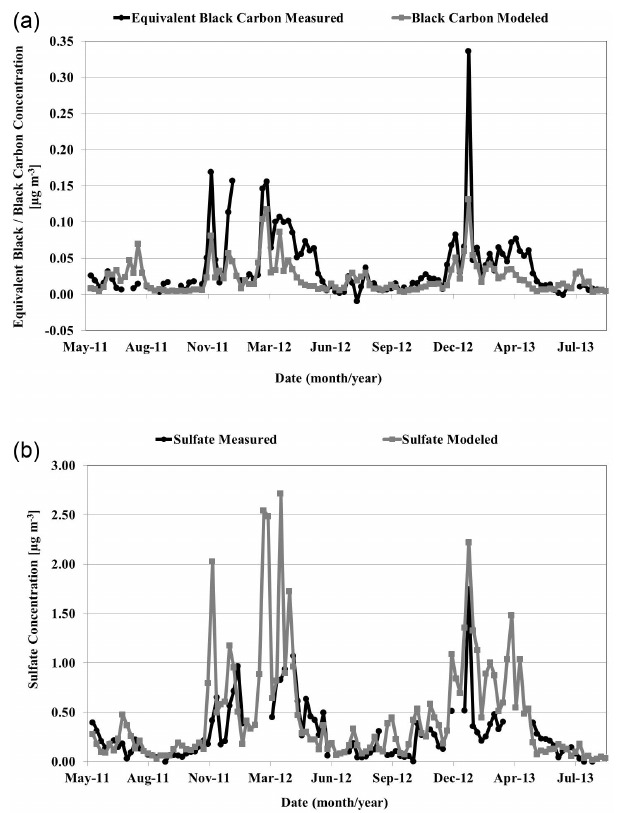
Figure 3. Comparison of measurement and model results from DEHM for (a) EBC/BC and (b) sulfate concentrations at VRS (Sta- tion Nord), North Greenland, during the time period from May 2011 to August